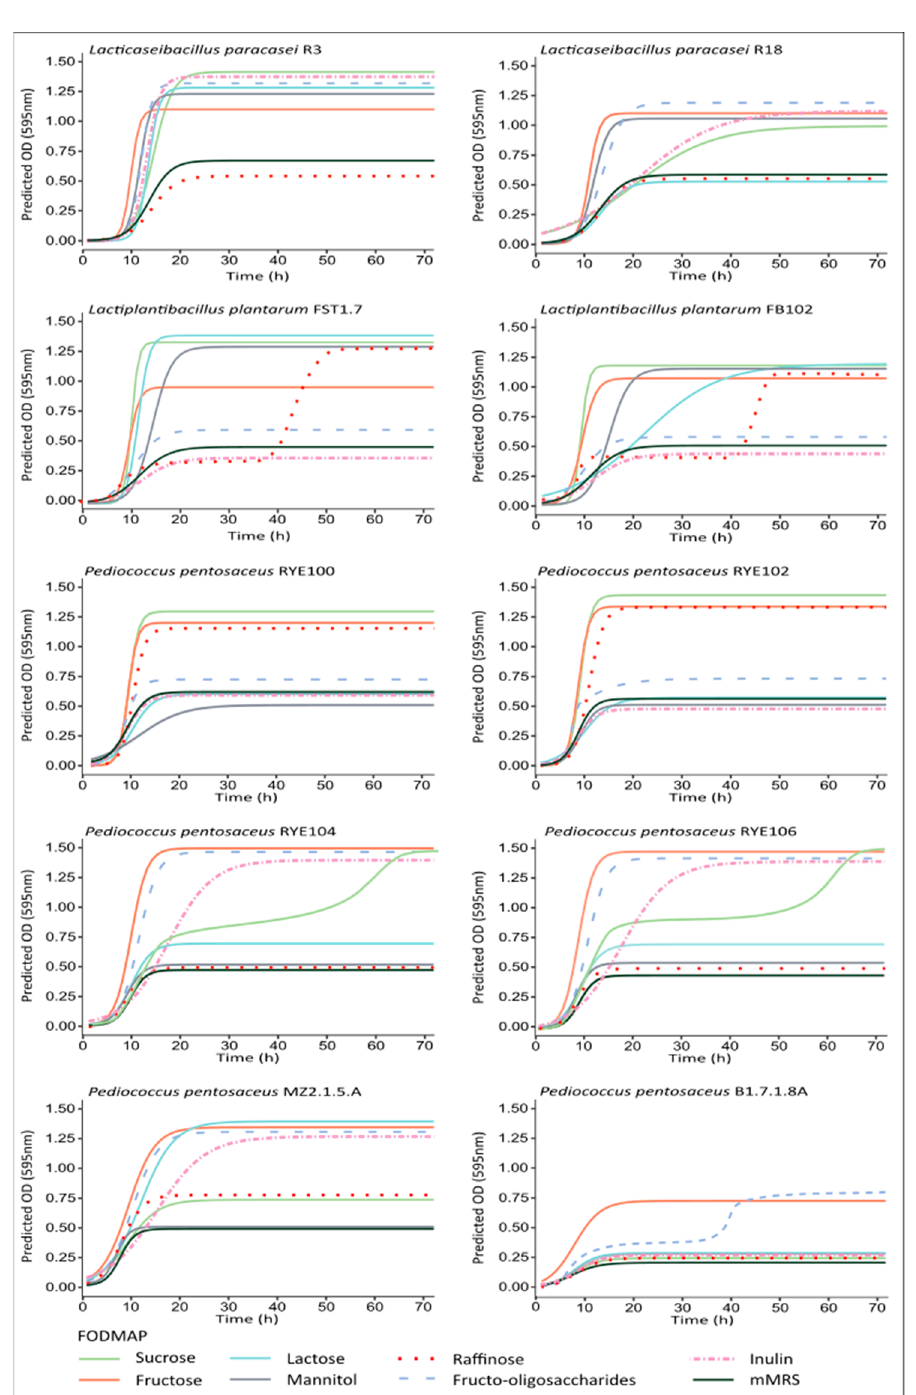
Figure A1. Growth curves of selected homofermentative lactic acid bacteria in carbohydrate-free mMRS broth and mMRS broth supplemented with individual FODMAPs (0.5% w / v ) based on microtitre FODMAPs fermentation assay (OD 595 nm, incubation at 30 °C over 72 h). Means of three independent trials were fitted into a standard form logistic equation. Growth on sucrose (green solid line), fructose (red solid line), lactose (blue solid line), mannitol (navy solid line), raffinose (dotted line), fructo-oligosaccharides (dashed line), and inulin (dash–dot line) and in mMRS (black) were analysed.